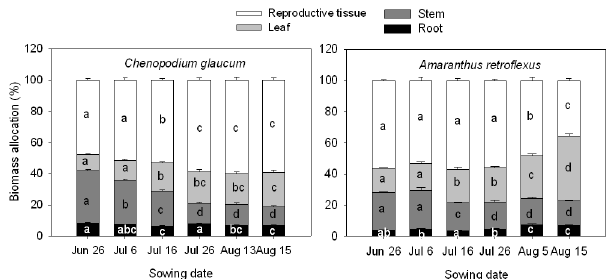
Fig 5. Results of multiple comparisons of differences in biomass allocation (% of total biomass, log transformed as needed) for Chenopodium glaucum and Amaranthus retroflexus among six sowing dates. Error bars are ± SE. Different letters for the same component indicate differences among sowing dates using Tukey ’ s multiple comparison test with a significance level of